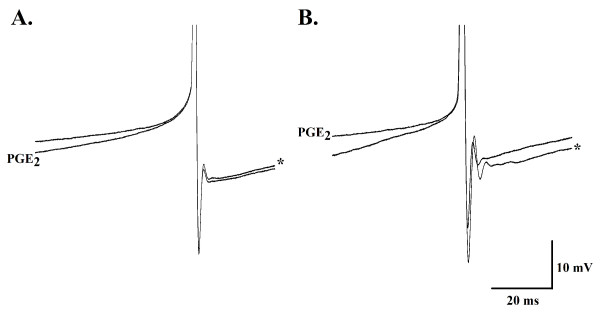
Averaged pre- and post-spike activity of a temperature insensitive VMPO neuron (A) and warm sensitive VMPO neuron (B). For each, averages of 10 action potentials (truncated) during baseline conditions and during perfusion with PGE2 (1 μM), are superimposed on the spike threshold (post-pike activity during PGE2 is indicated by an asterisk). These averages do not include pre-spike activity that contained putative postsynaptic potentials. For the temperature insensitive neuron in A, the rate of rise of the depolarizing prepotential increased from 0.17 mV·mSec-1 to 0.27 mV·mSec-1. For the warm sensitive neurons in B, the rate of rise of the depolarizing prepotential decreased from 0.38 mV·mSec-1 to 0.18 mV·mSec-1.